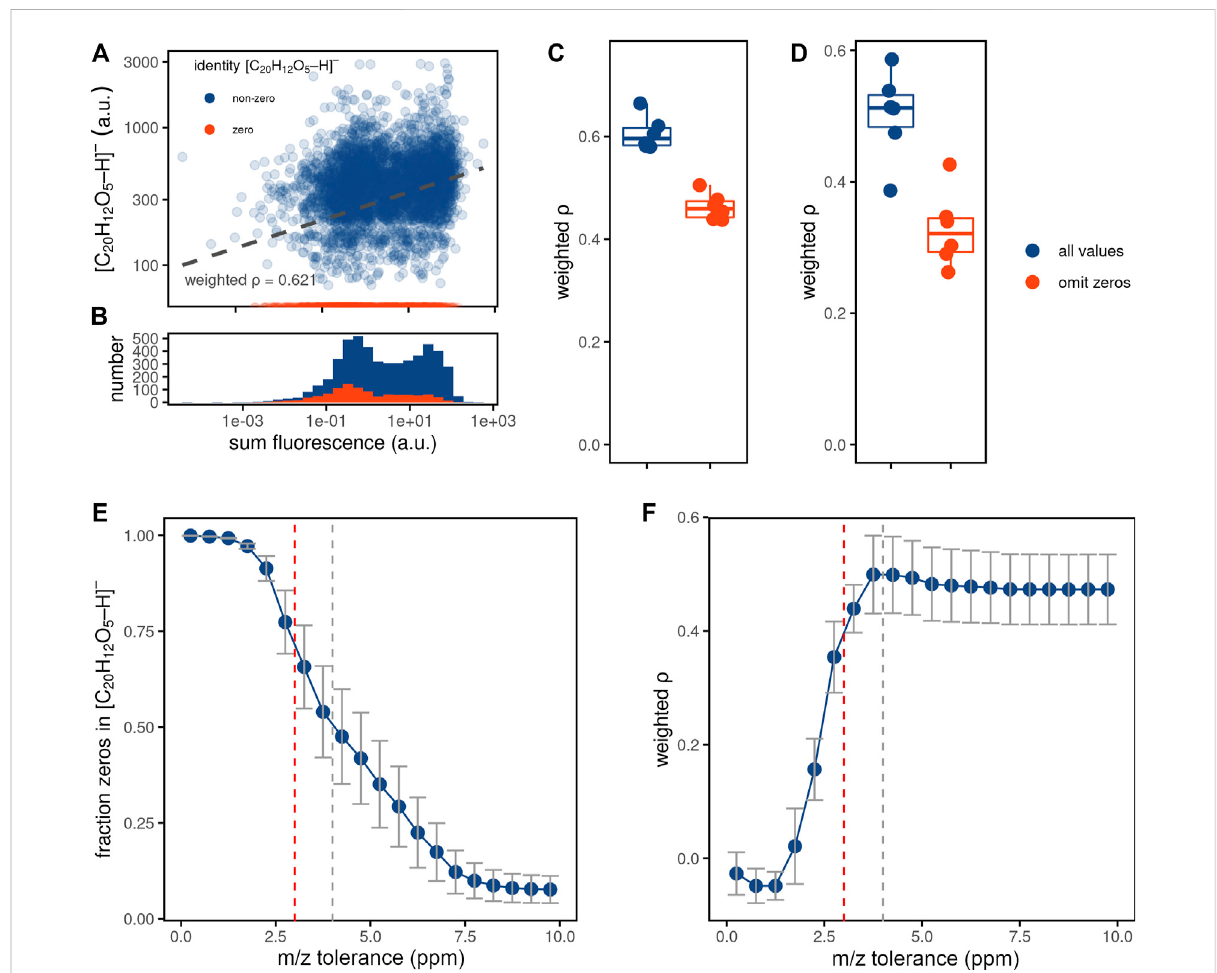
FIGURE 3 Investigating mass spectrometry drop-outs. (A) Representative scatter plot (belonging to one replicate) showing relations between the fl uorescenceintensitiesandMSintensitiesfor fl uorescein,measuredfortheablatedregions. (B) Histogramofthe fl uorescenceintensitiesforablated regions with non-zero (blue) and zero (red) MS intensities for the fl uorescein ion. (C,D) Boxplots with density-weighted Spearman correlations between fl uorescenceandMSintensitiesof fl uoresceineitherfortheablatedregions (C) orcells (D) usingtheWAmethod(samplingproportion of 0.3, m/z tolerance of 4 ppm) for 6 replicates, using all ablated regions (blue) or only those with non-zero MS intensities for fl uorescein (red) from panels (A,B) . (E,F) The effect of increasing peak integration m/z tolerance on the fraction of zeros in the input measurements (E) and correlation between fl uorescenceandMSintensity for fl uorescein (F) .Pixel-cell deconvolution methodswereperformedasdescribedfor panel (D) .Data points indicatethemeanvaluesandstandarddeviationofthe6replicates,thedashedlinesshowthe3 ppm(red,defaultinMETASPACE)or4 ppmtolerance found to be optimal for this experiment